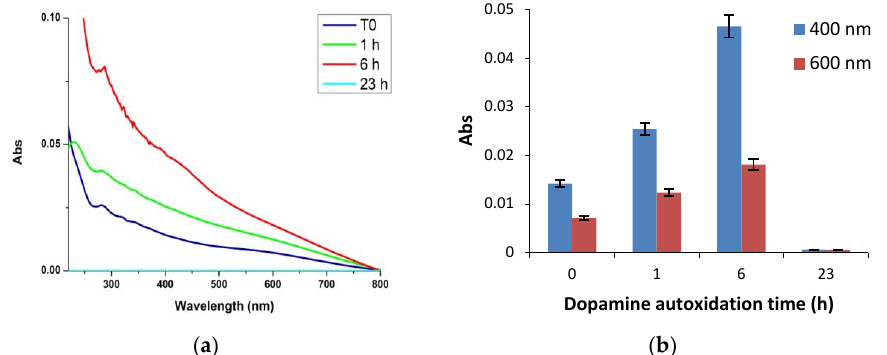
Figure 4. Kinetics of polydopamine (PDA) film formation . ( a ) Evolution of the ultraviolet–visible (UV–vis) spectra of PDA film formation with quartz substrates dipped into the mixture for 1 h at different reaction times. ( b ) Absorbance of the films at two selected wavelengths. Data are shown as mean ± standard deviation (SD) of three independent experiments.